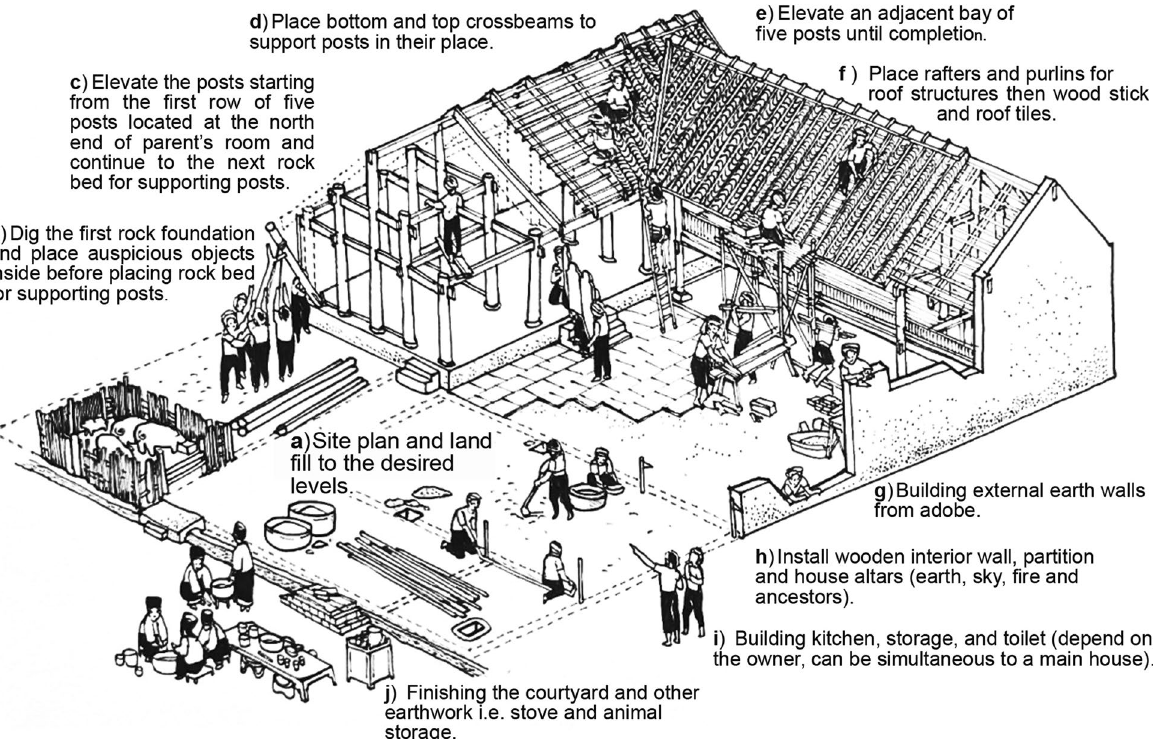
Fig. 6 The process of constructing a house (Source: the